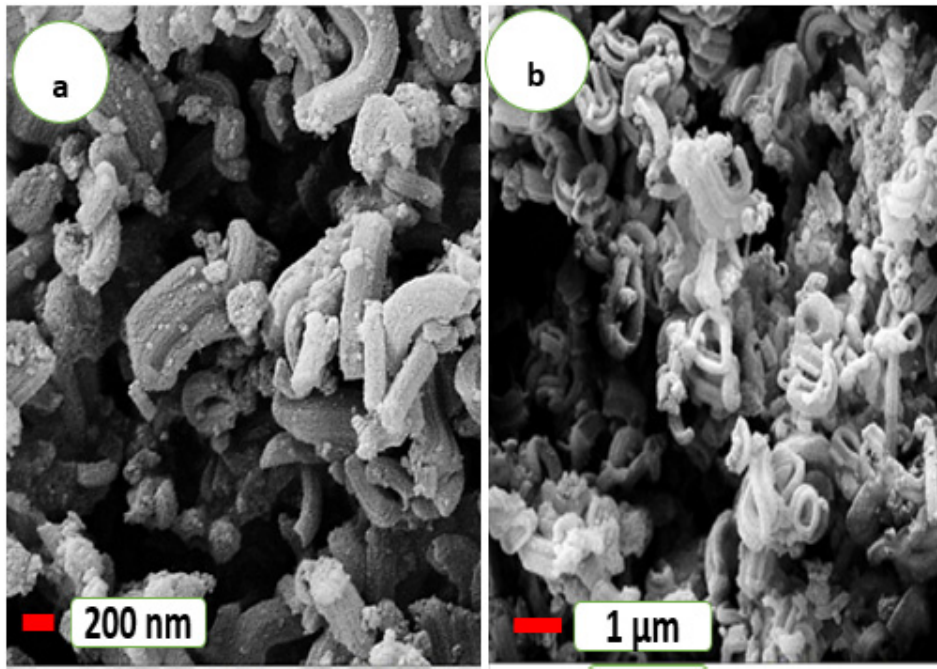
Figure 3. SEM images of ( a ) SBA-15 and ( b ) SBA-Pr-Is-TAP.